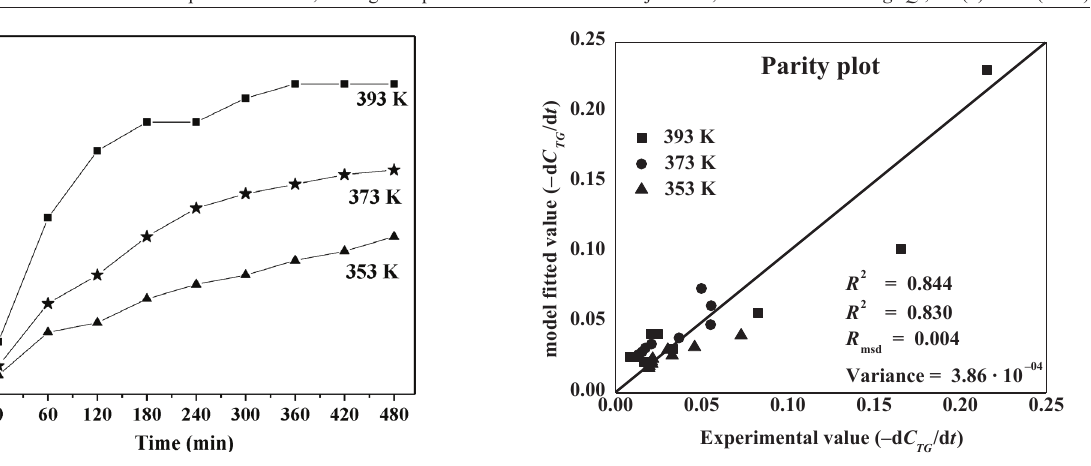
Fig. 11 – Parity plot between predicted and experimental dC − for Karanja oil values of TG dt